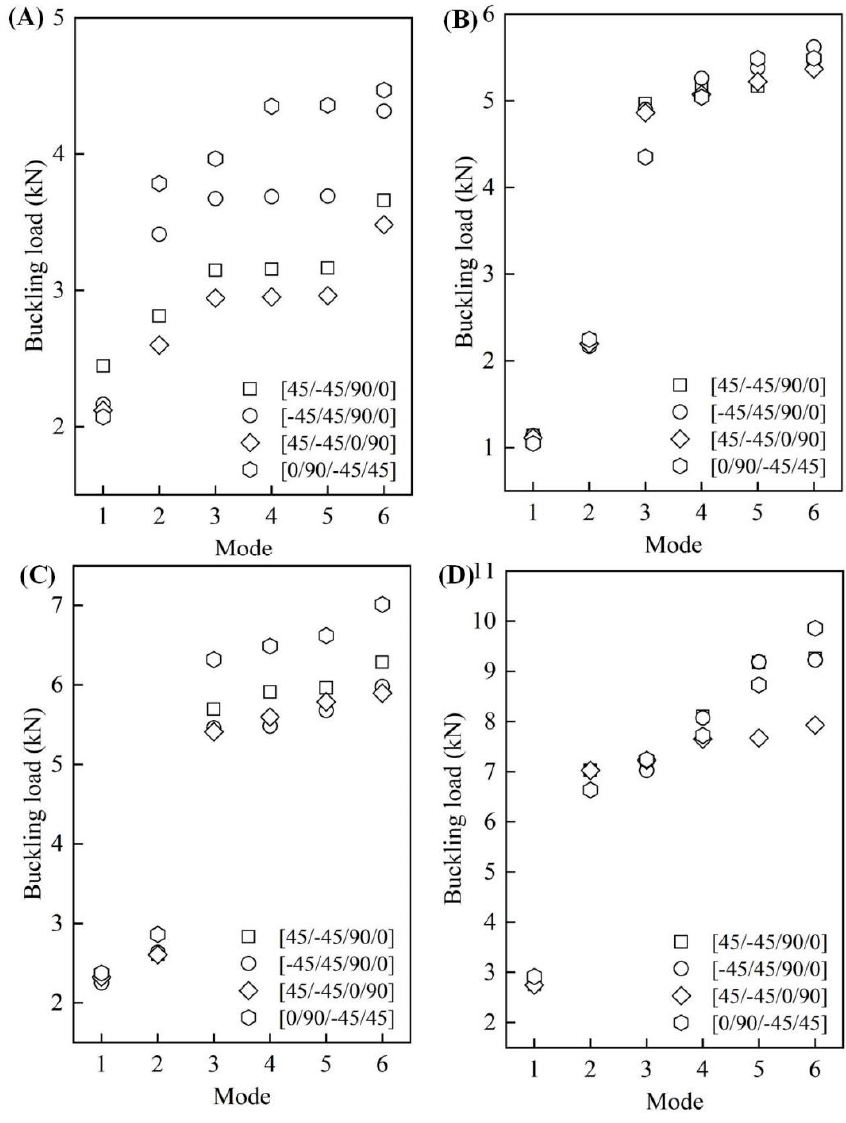
Figure 7. The influences of the layer order on the buckling loads. ( A ) θ = 10°; ( B ) θ = 50°; ( C ) θ = 90°; ( D ) θ = 130°.